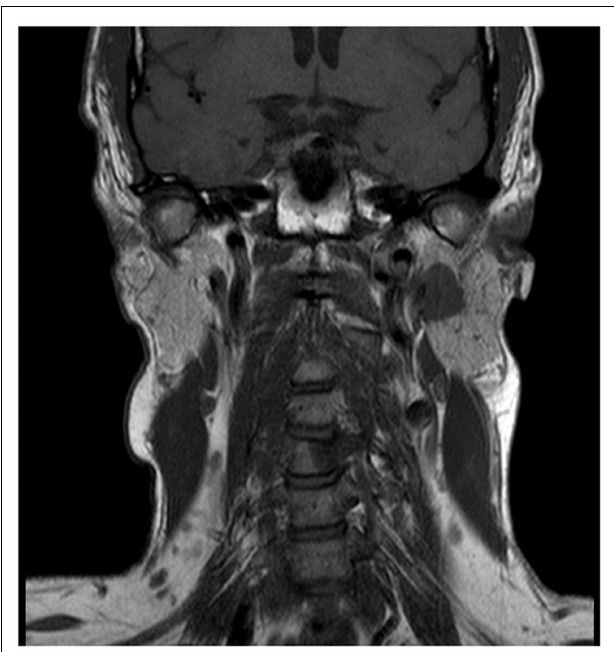
FIGURE 1 | Magnetic resonance imaging showing the left parotid gland mass in the coronal plane .